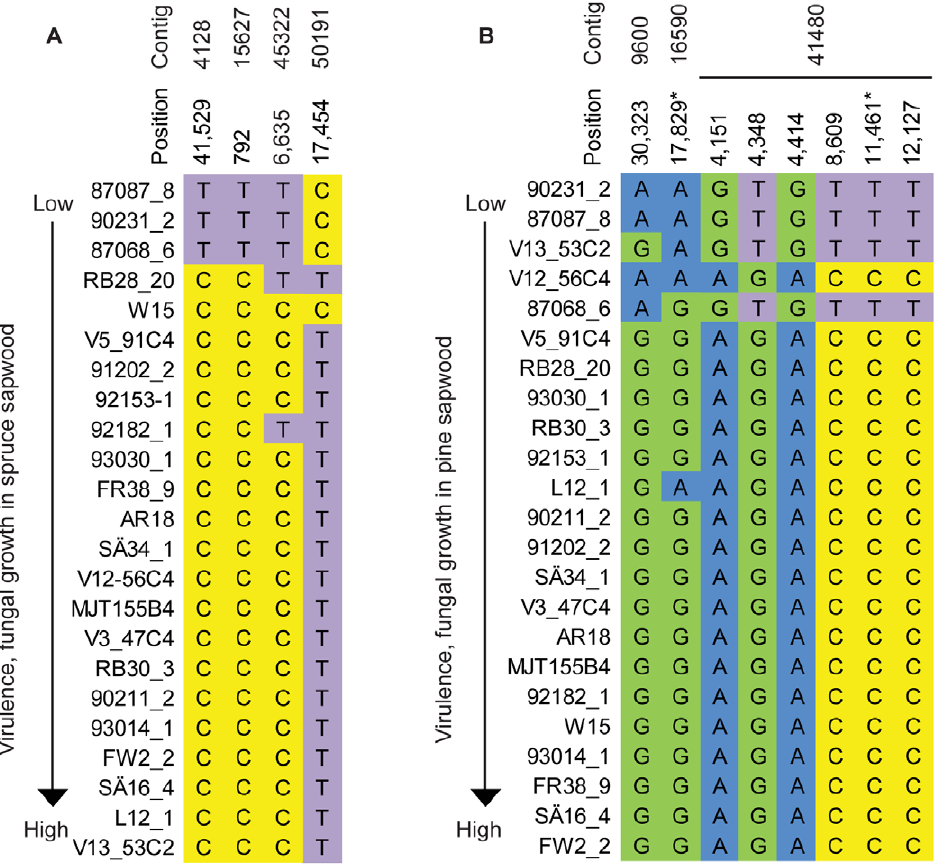
Table 4. Data for the contigs with SNPs associated with virulence.